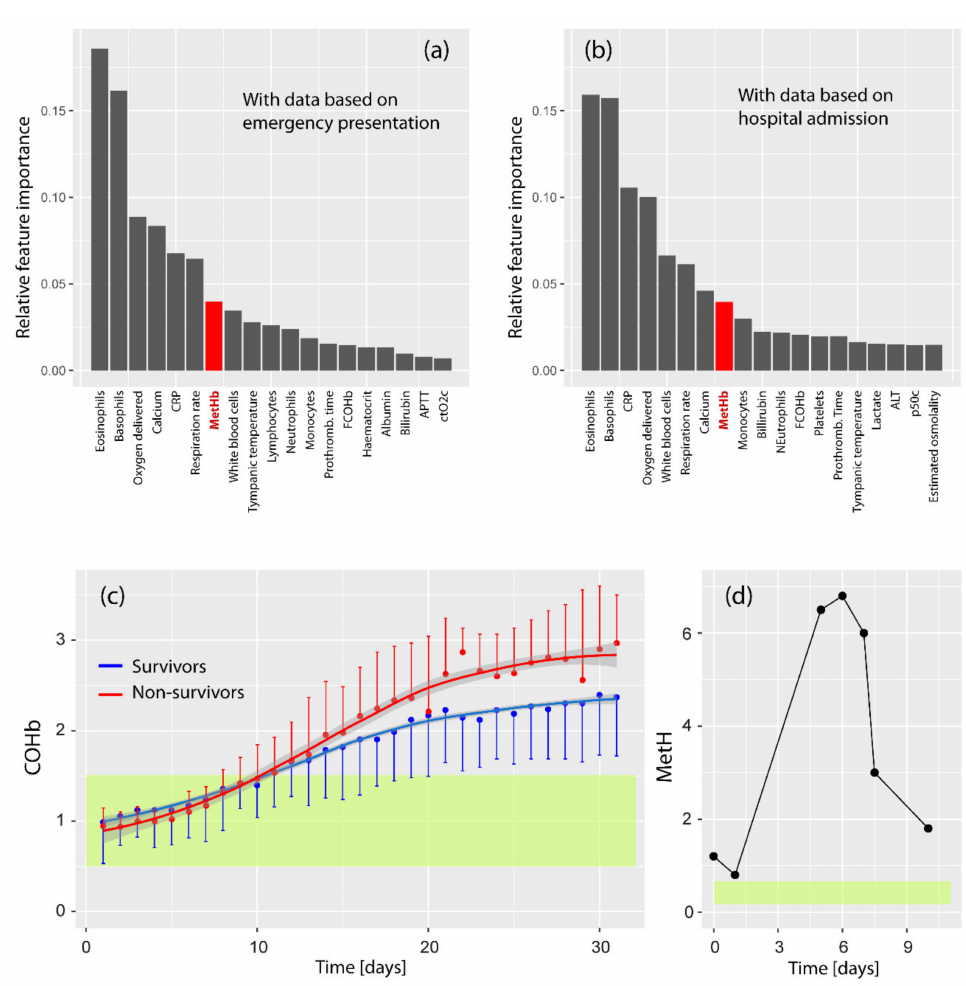
Figure 3. ( a , b ) Relative feature importance in predicting COVID-19 according to the study of Soltan et al. [19]. Two models were built, one with data based on emergency presentation ( a ) and one with data based on hospital admission. MetHb was a relevant parameter in both models (indicated in red). ( c ) COVID-19 non-survivors ( n = 22) show a steeper and higher increase of COHb during the curse of the disease compared to COVID-19 survivors ( n = 41), according to the study of Paccaudi et al. [24]. The two COHb time-series are statistically significantly different. The yellow bar refers to the COHb reference ranges for healthy non-smokers [16]. ( d ) Time-course of MetHb of a COVID-19 patient reported by Palmer et al. [22]. The yellow bar refers to the MetHb reference range for healthy non-smokers [15]. The figures show data extracted from the original figures of the respective